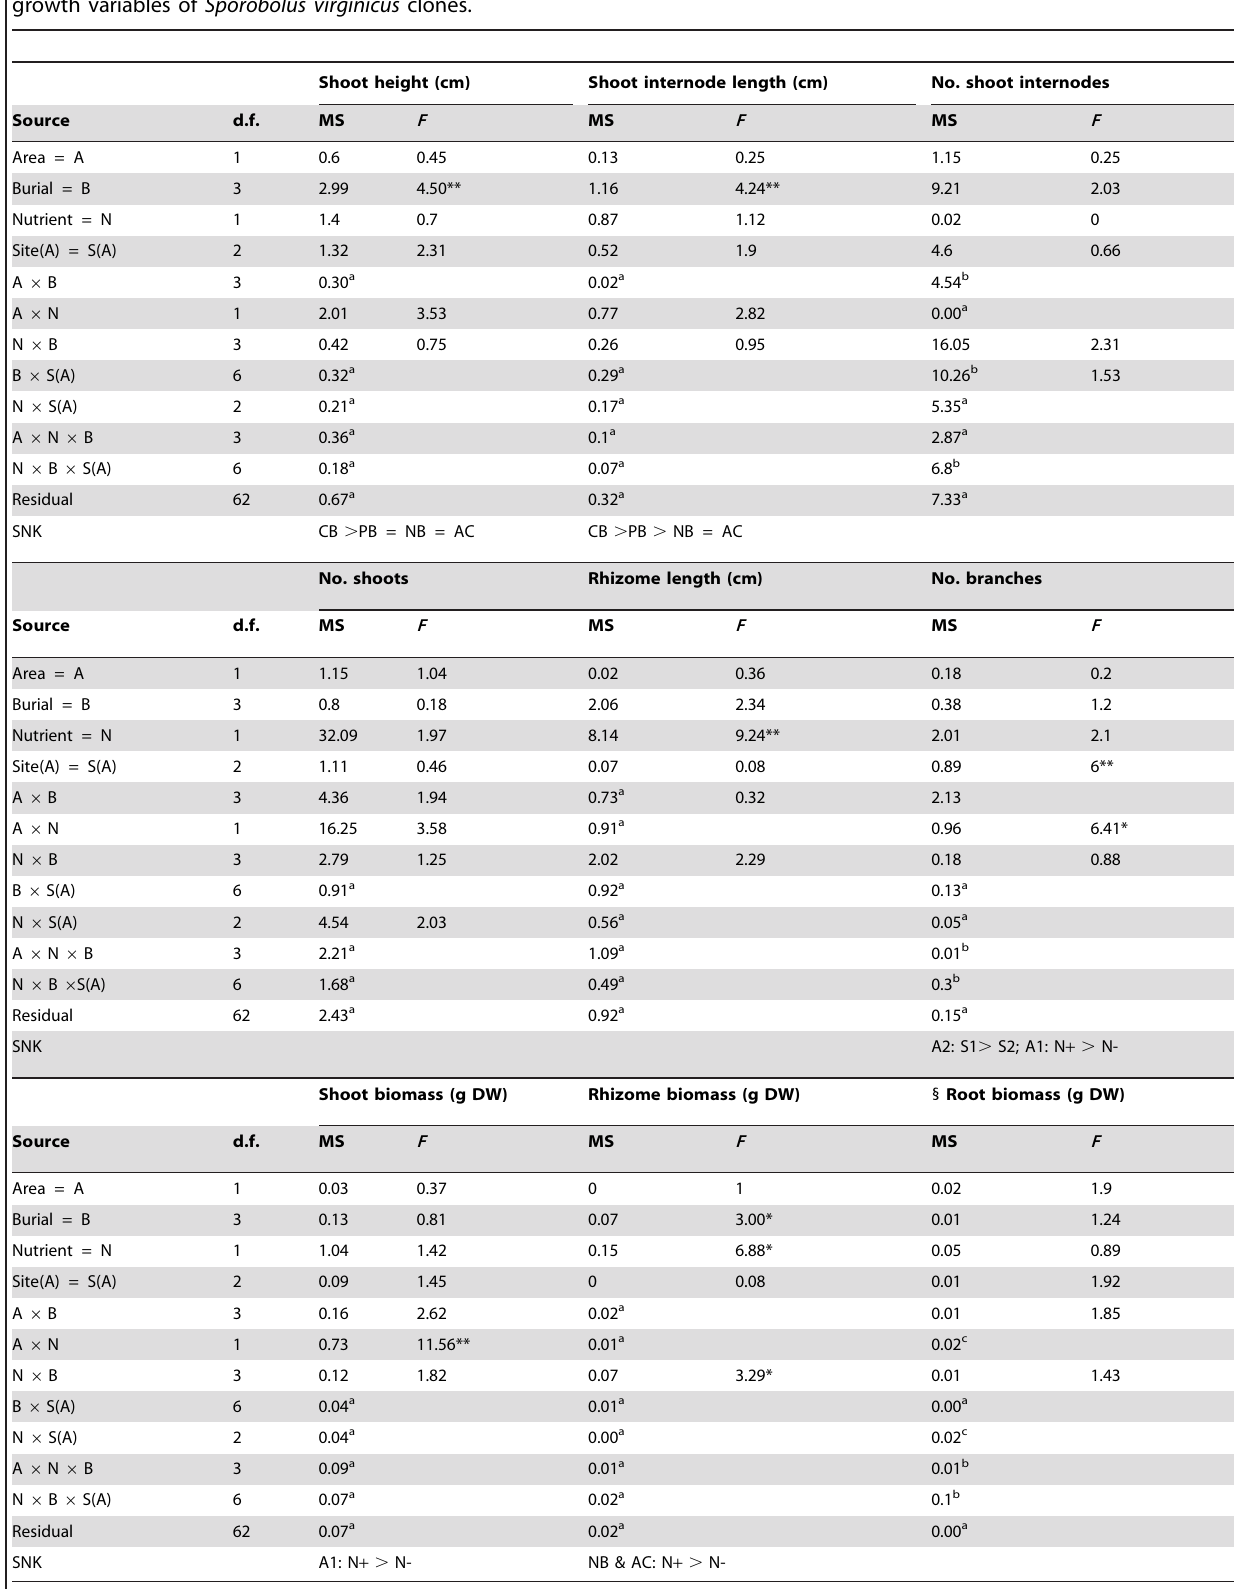
Table 1. ANOVAs for the effects of area, site, burial height, nutrient availability and their interactions on morphological and growth variables of Sporobolus virginicus